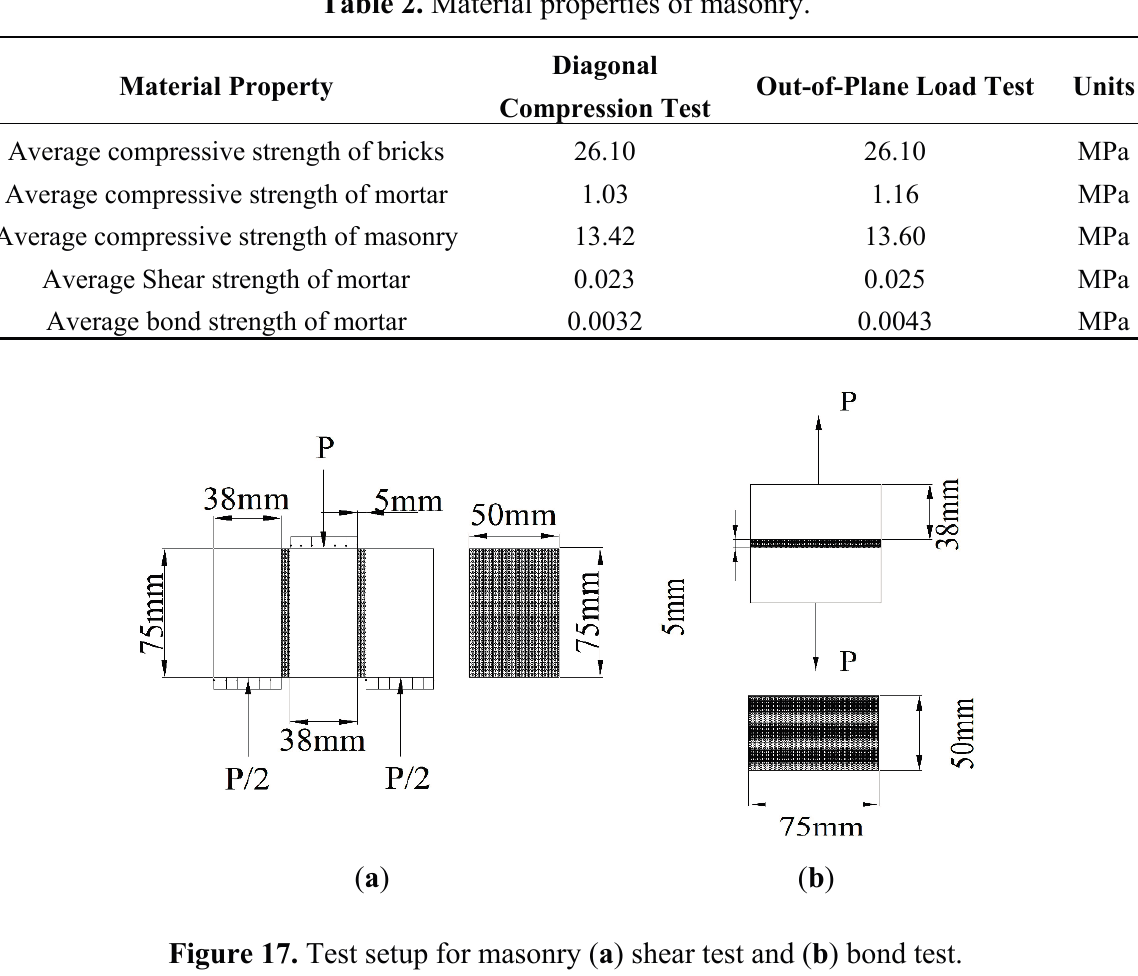
Table 2. Material properties of masonry.